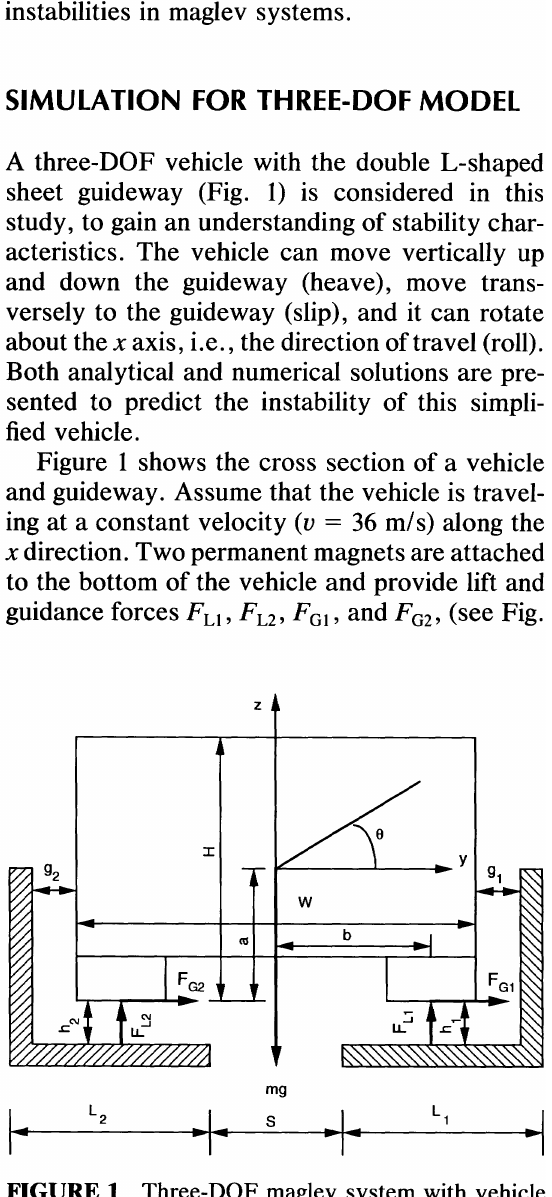
FIGURE 1 Three-DOF maglev system with vehicle operating on double L-shaped aluminum sheet